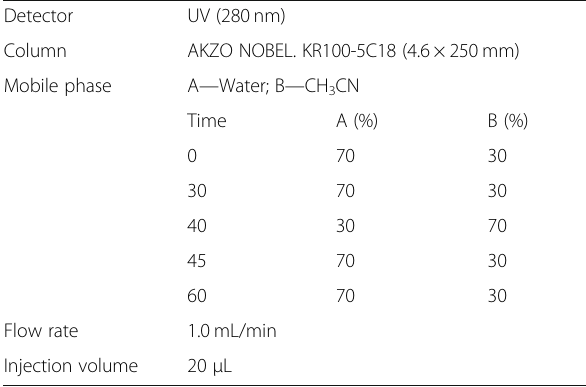
Table 4 HPLC analysis conditions of AI 1~3